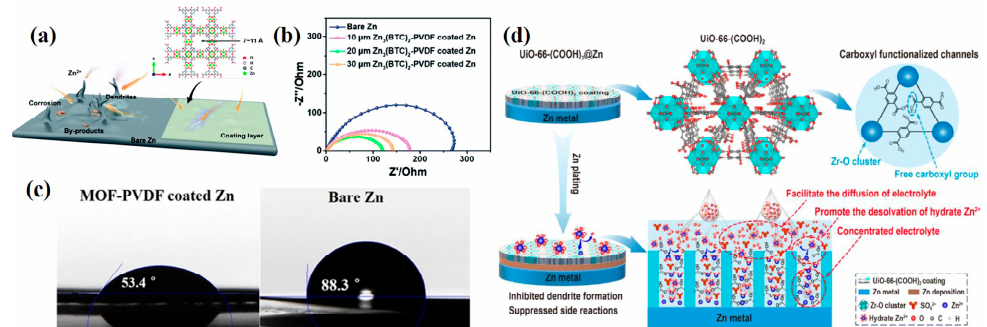
Figure 8. ( a ) Schematic illustration of the morphology evolution of bare and Zn-BTC coated Zn anodes during Zn stripping/plating and ( b ) EIS spectra of the symmetric cells [78]. Copyright 2022, Royal Society of Chemistry. ( c ) Images of contact angles between the electrolyte and different anodes [79]. Copyright 2019, American Chemical Society. ( d ) Schematic illustration of the functional mechanism of the UiO-66-(COOH) 2 coating layer for protecting the Zn anode [80]. Copyright 2023,